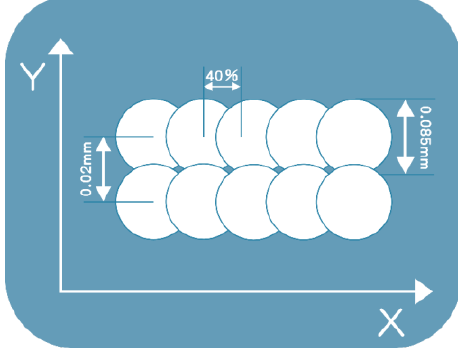
Figure 2. Schematic diagram of laser cleaning parameter setting.